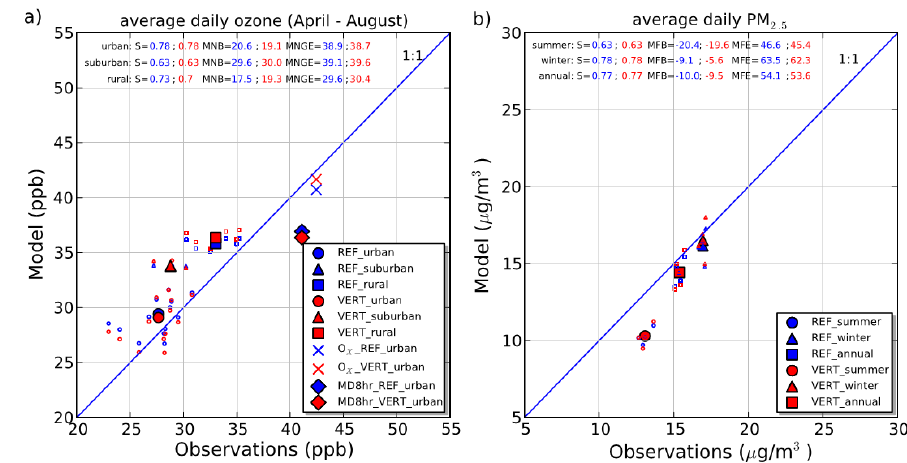
Figure 6. Scatter plots and scores for the sensitivity test on the CTM’s vertical resolution for ozone and PM 2 . 5